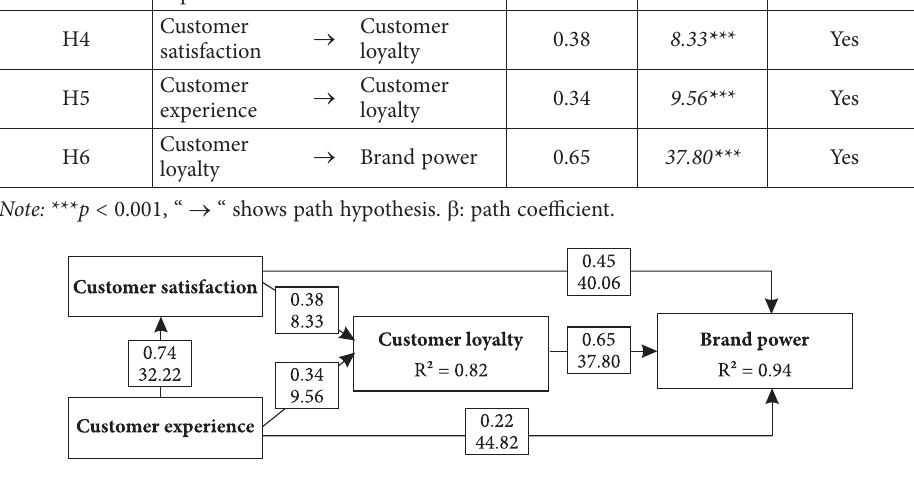
Figure 2. Path diagram for